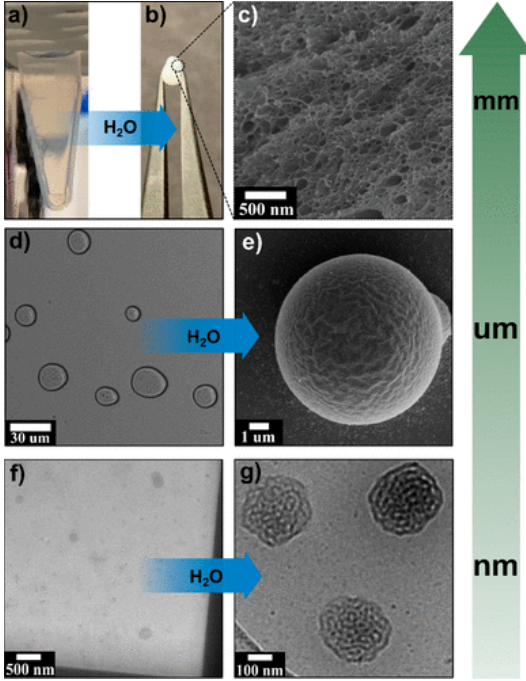
Figure 5. Macroscale to nanoscale self-assembly formation of PEO 45 -b- PMMA 300 system. ( a ) Photo- graph of a macrophase-separated coacervate solution of PEO 45 -b-PMMA 300 at ϕ W = 0.25 in dioxane. ( b ) Photograph of a millimeter-size pellet formed by driving the coacervate phase to self-assembly via excess water addition. ( c ) SEM image of a cross section of the pellet formed showing the bicontinuous microstructure within the self-assembled pellet. ( d ) Bright-field optical microscopy image of the dispersed coacervate droplets of PEO 45 -b-PMMA 300 at ϕ W = 0.25 in the dioxane mixture. ( e ) SEM image of the microparticles self-assembled from the dispersed coacervate solution via excess water addition. ( f ) In situ TEM image of nanocoacervates formed using PEO 45 -b-PMMA 300 . ( g ) Cryo-TEM image of continuous structures formed at ϕ W > 0.3 water in dioxane on the cryo-TEM grid. Reprinted with permission from Macromolecules, 2020, 53, 6078. Copyright 2020 American Chemical